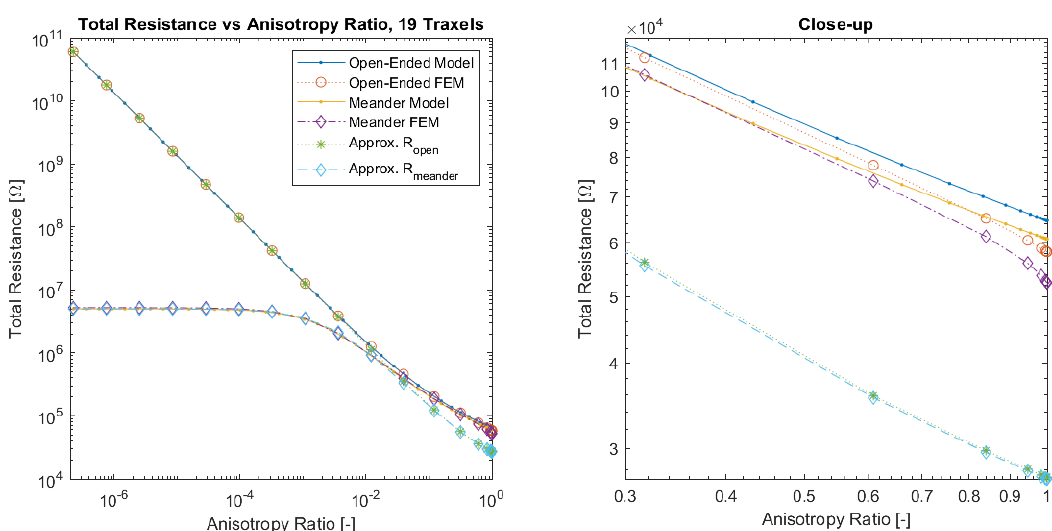
Figure 15. A comparison of the total resistance as a function of anisotropy ratio for open-ended and meandering traxels between the model, FEM simulation, and resistance approximation results. The errors between the model and FEM results occur at an anisotropy ratio that is close to 1 due to 2D-conduction effects.